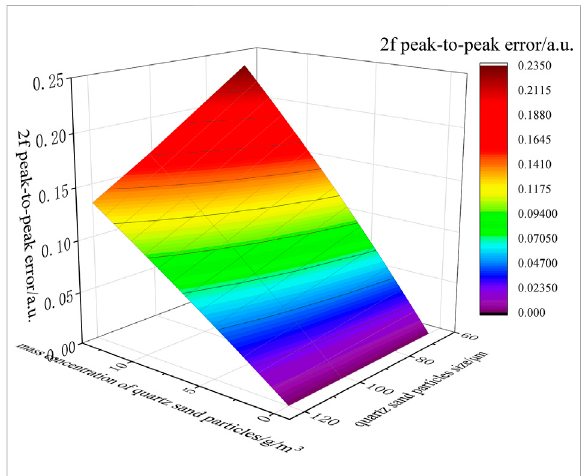
FIGURE 6 Relationship between the 2f peak-to-peak error of NO and the quartz sand mass concentration and size.